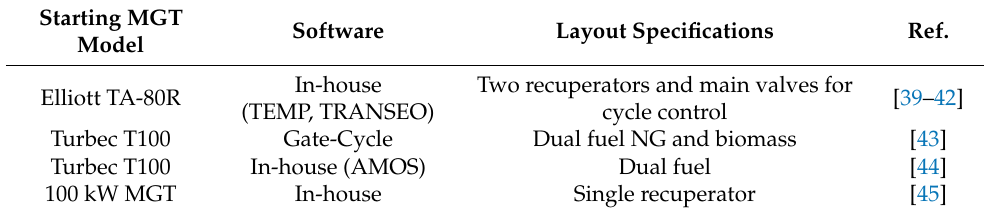
Table 3. Externally fired micro gas turbine reviewed.